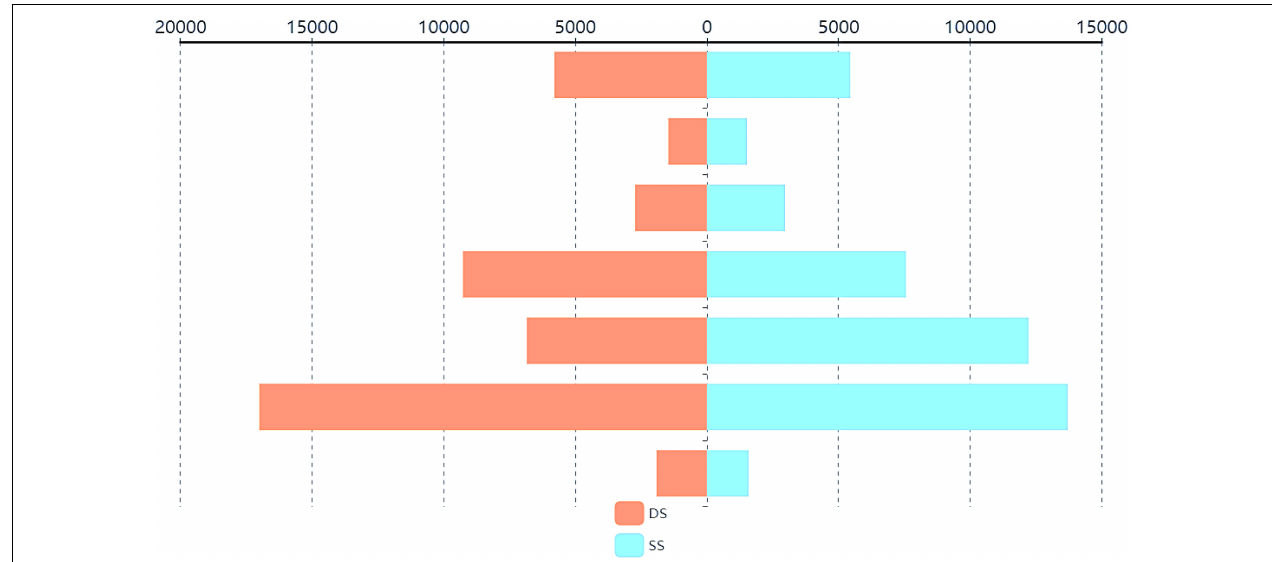
FIGURE 6 | Total energy industry supply and demand in Shaanxi Province in